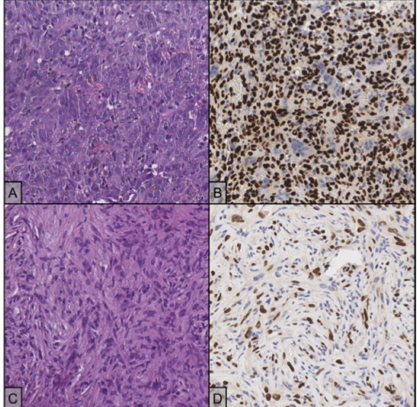
Figure 6. ( A ) Typical histology with osteoclast-like giant cells admixed with mononuclear cells (H&E stain, 20 × ). ( B ) Mononuclear cells show immunoreactivity for H3F3A, while the giant cells are negative (20 × ). ( C ) Recurrent disease shows different morphological features from the primary neoplasm, with proliferation of an atypical spindle cell population and no evidence of giant cells. (H&E stain, 20 × ). ( D ) Neoplastic cells maintain focal positivity for H3F3A immunostaining (20 ×